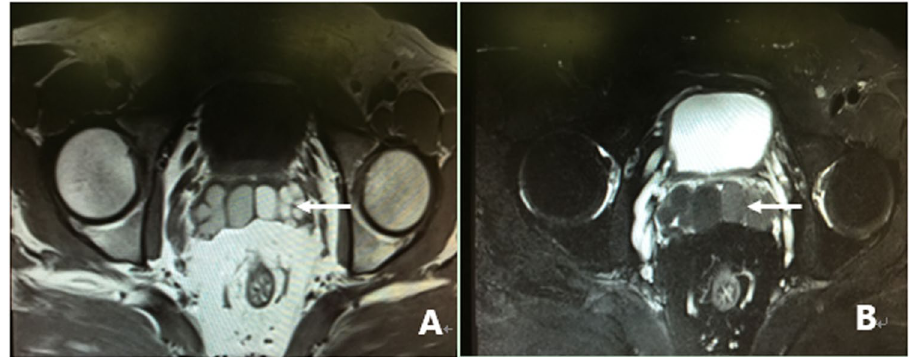
Figure 6. MRI image of EDO. ( A ) The image shows obvious dilatation or enlargement in both sides of the SV. The SV presents intermediate-high signal intensity on T1WI. ( B ) Both sides of the SV present as low signal intensity on T2WI. This pattern suggests that EDO is accompanied with a fresh hemorrhage in both sides of the